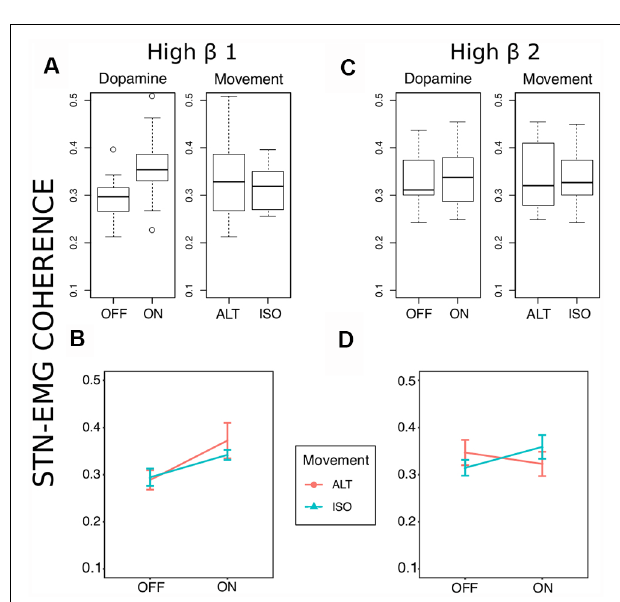
FIGURE 3 | Coherence statistics. (A,B) Stronger high beta coherence soon after movement onset (50–150 ms) was observed in the medication ON state, though this was only marginally significant ( F ( 1,6 ) = 5.41, uncorrected p = 0.059, η 2 p = 0.47). (C,D) A significant dopamine × movement type effect ( F ( 1,6 ) = 9.37, uncorrected p = 0.02, η 2 p = 0.61) on high beta coherence was observed later between 300 and 500 ms after movement onset.